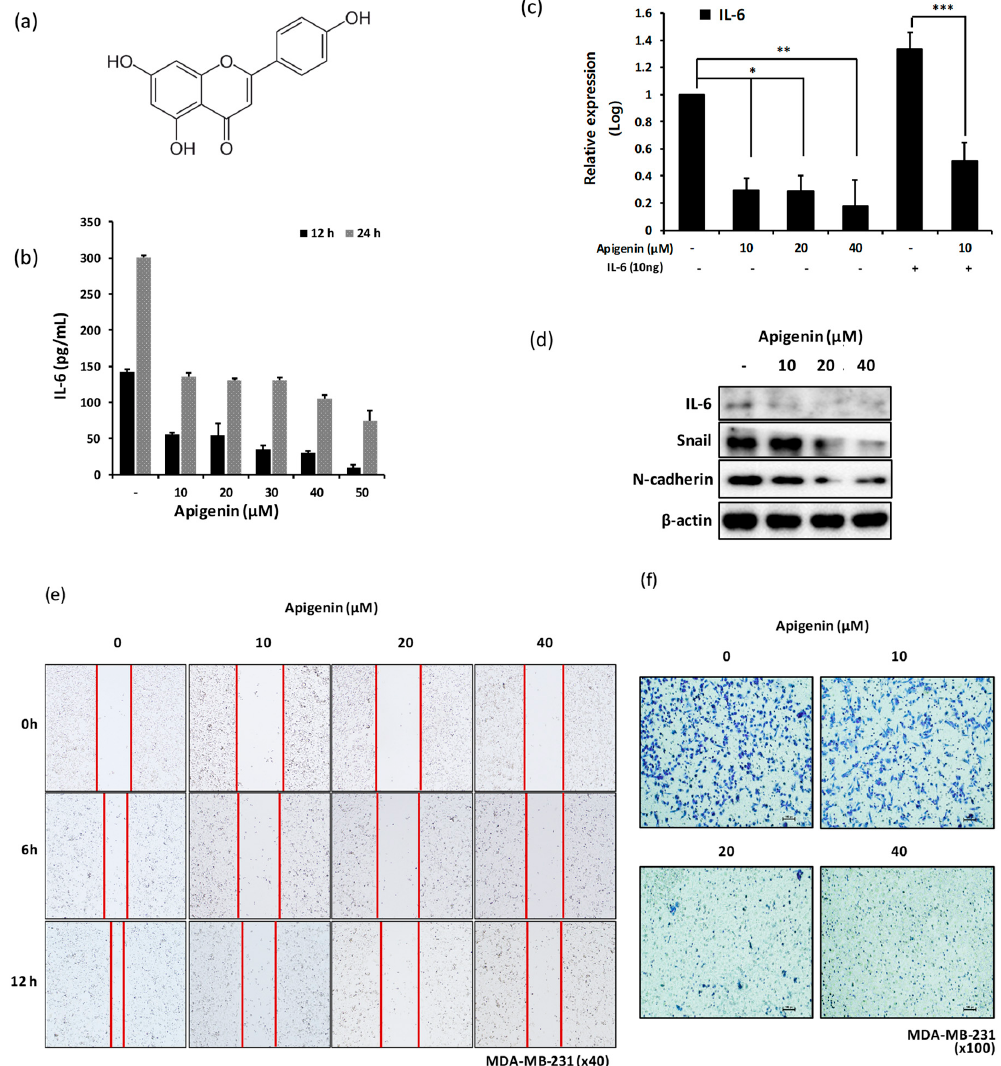
Figure 6. Apigenin treatment decreases the expression of snail and N-cadherin via IL-6 inhibition in MDA-MB-231 cells. MDA-MB-231 cells were plated at a density of 5 × 10 5 cells/well in a six-well plate and incubated with different concentrations of apigenin (10 to 50 μ M) for 24 h. The cells were harvested for western blot analysis and qPCR, and the supernatants were used for ELISA. ( a ) The structure of apigenin. ( b ) Production of IL-6 by ELISA. ( c ) Relative mRNA expression of IL-6 by qPCR. ( d ) Expression of IL-6, snail, and N-cadherin proteins by western blot analysis. Migration and invasiveness of MDA-MB-231 cells were assessed using scratch motility assay and invasion assay, respectively. ( e ) Migratory capability of MDA-MB-231 cells. For scratch motility assay, cells were plated at a density of 2 × 10 5 cells/well in a 24-well plate and treated with different concentrations (0, 10, 20, and 40 μ M) of apigenin for different time points (0, 6, and 12 h). ( f ) Invasive capability of MDA-MB-231 cells. For invasion assay, a transwell insert was coated with Matrigel. Cells were seeded in the upper chamber of transwell at a density of 2–5 × 10 5 cells/mL and treated with different concentrations of apigenin (0, 10, 20, and 40 μ M). After 24 h of incubation, cells were stained with crystal violet (scale value is 100px). Significant differences are shown: * p < 0.05, ** p < 0.001, *** p < 0.002.